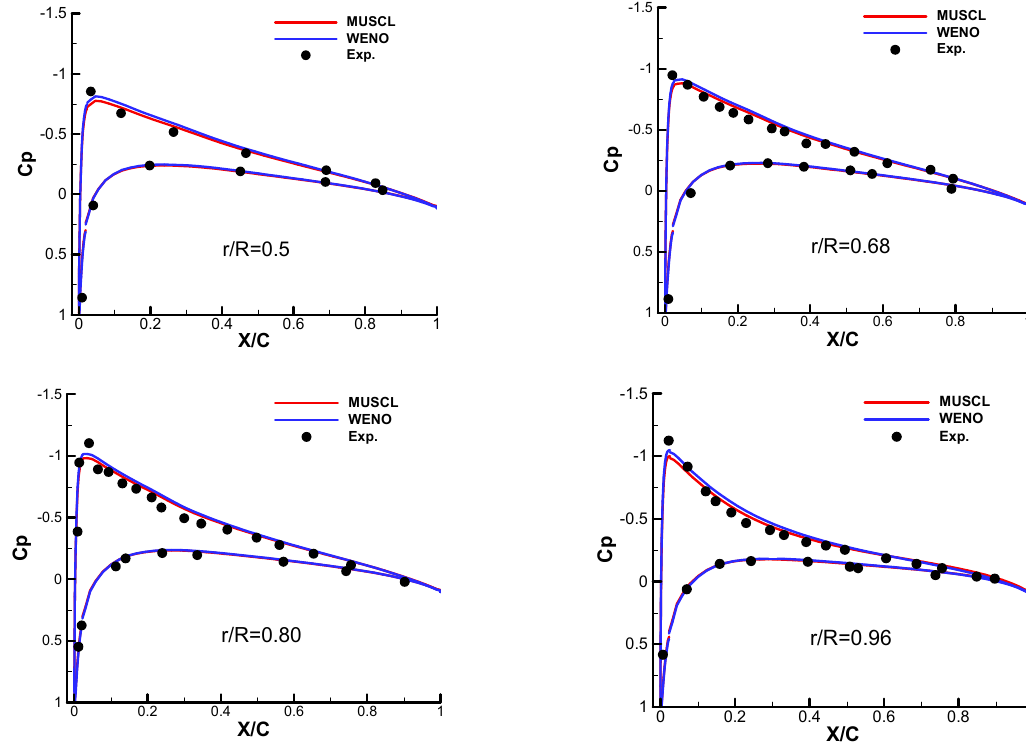
Figure 5. Comparison of pressure distribution at circumferential positions.